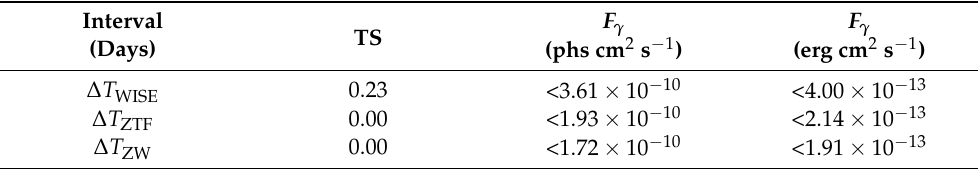
Table 2. Results of the stacking analysis for all the sample sources for different time intervals.